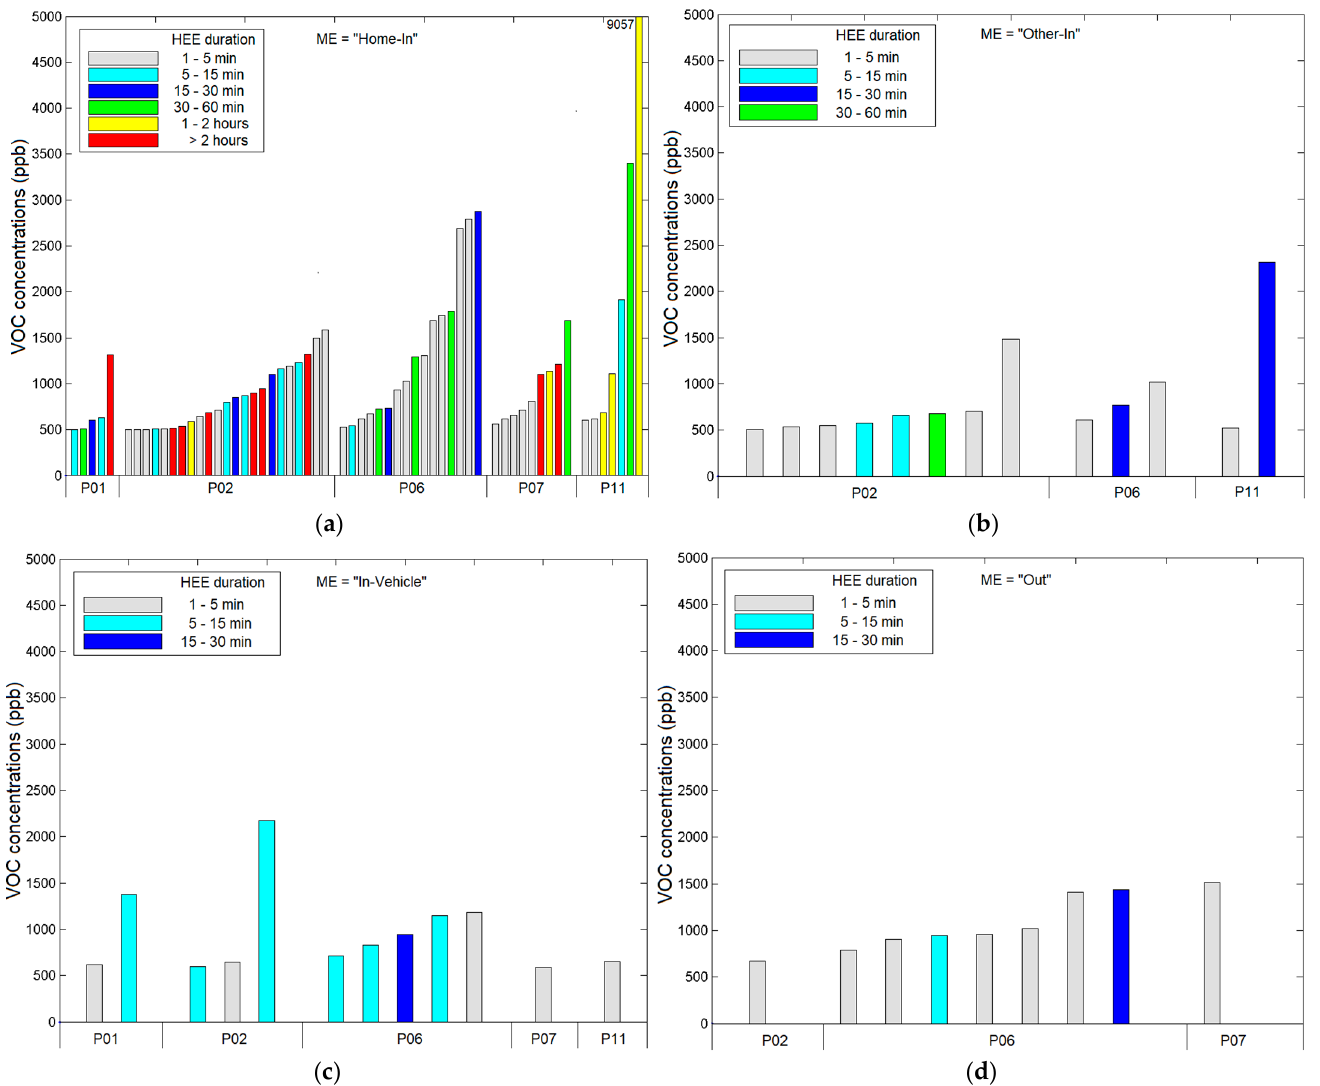
Figure 4. Characteristics of the HEEs within each ME: ( a ) “Home-In”; ( b ) “Other-In”; ( c ) “In-Vehicle”; ( d ) “Out”.